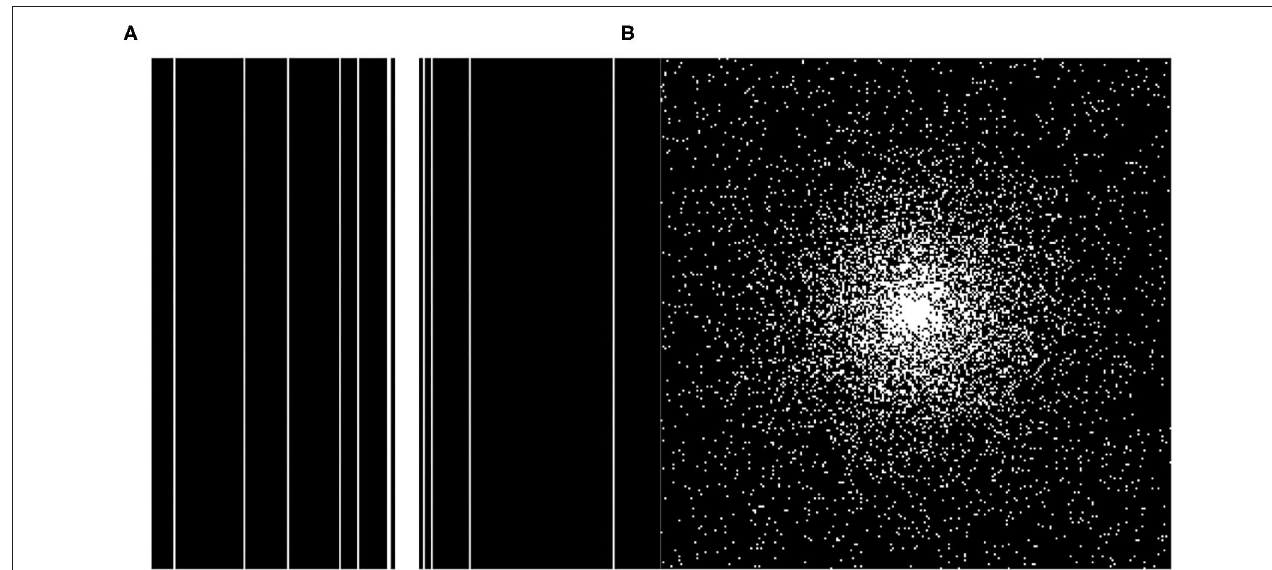
FIGURE 4 | The two different under sampling masks. (A) 1D Gaussian mask and (B) 2D Gaussian mask.